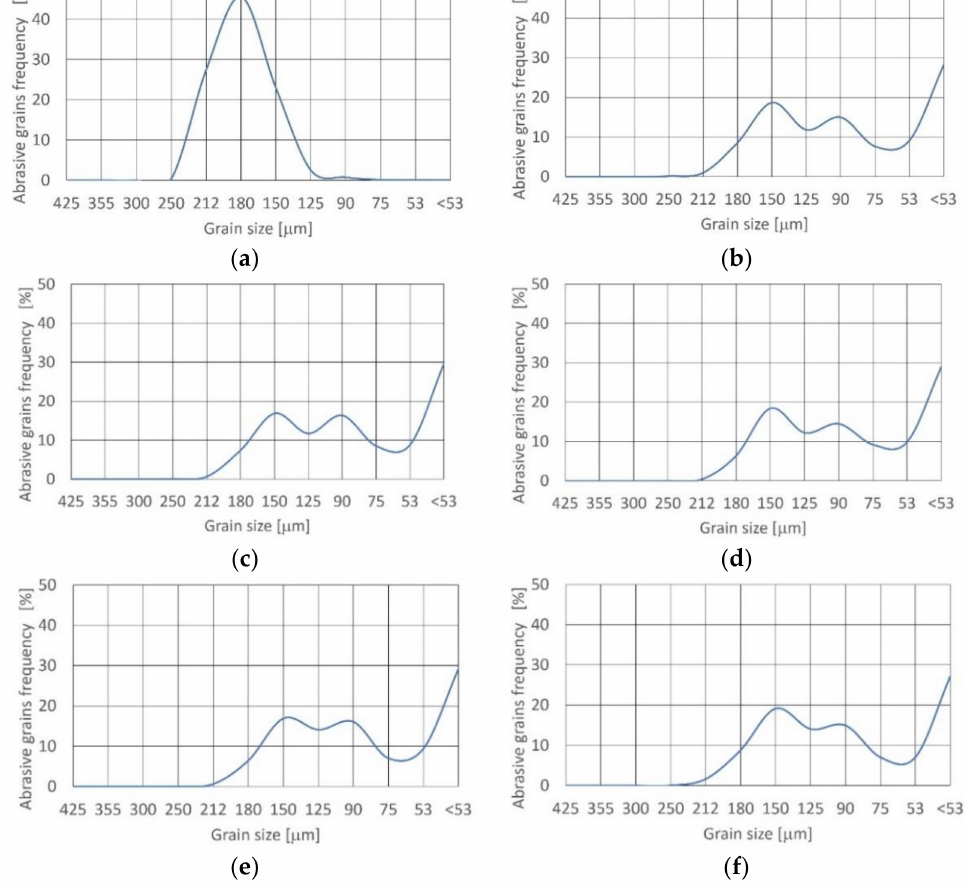
Figure 5. Size distribution of corundum grain at concentration: ( a ) fresh; ( b ) 15%; ( c ) 17.5%; ( d ) 20%; ( e ) 22.5%; and ( f )